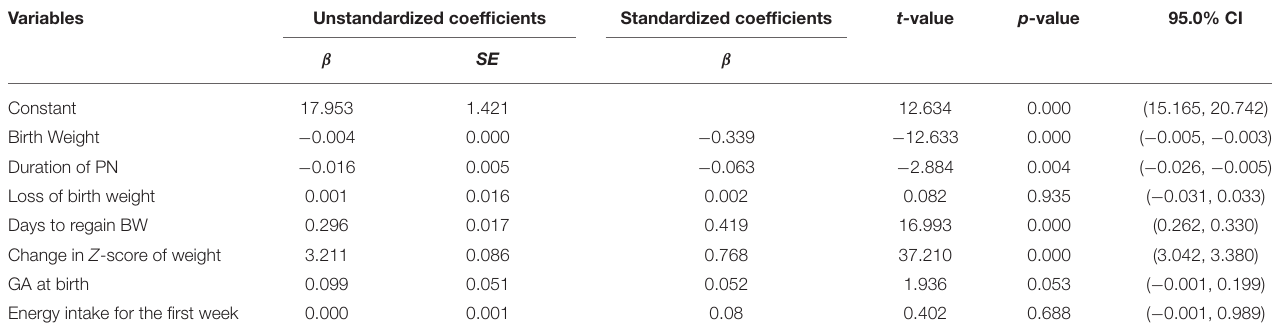
TABLE 5 | Multivariate linear regression analysis of influencing factors of weight growth